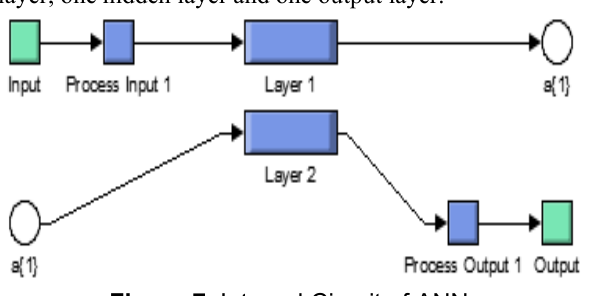
Figure 6. ANN based DC link voltage controller